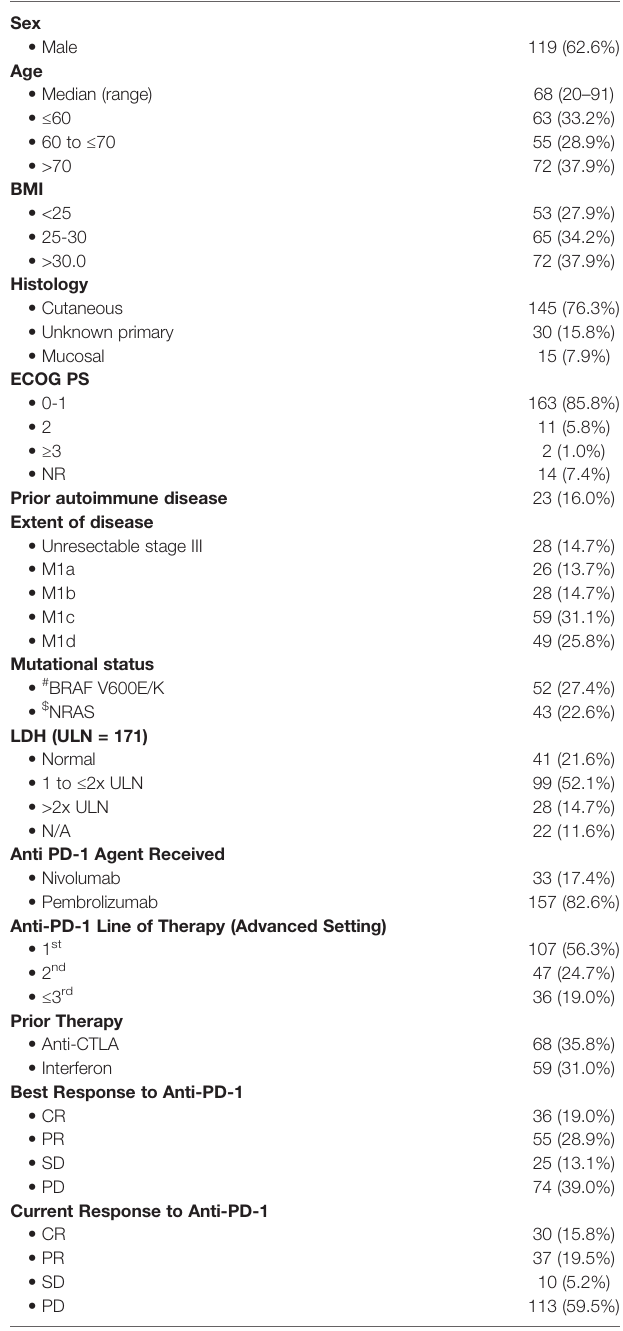
TABLE 1 | Baseline characteristics of PD-1 treated advanced melanoma